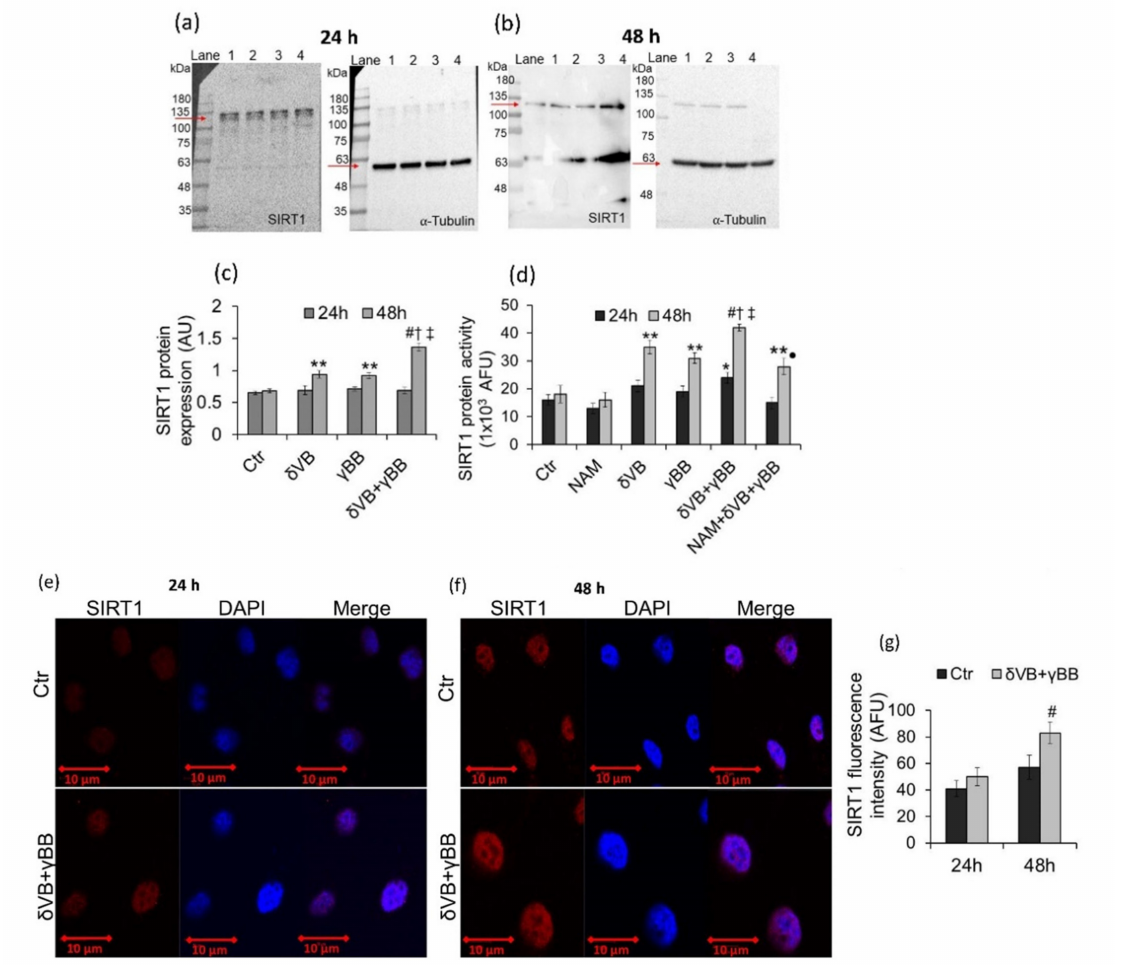
Figure 5. SIRT1 activation by δ VB and γ BB. ( a – c ) SIRT1 protein expression levels were determined in Cal 27 cells after exposure to δ VB (2 mM), γ BB (2.5 mM), or δ VB + γ BB (2 mM + 1.62 mM). Results were expressed as arbitrary units (AU) with ** p < 0.01 vs. Ctr, # p < 0.001 vs. Ctr, † p < 0.05 vs. δ VB, ‡ p < 0.05 vs. γ BB. Lane 1 = Ctr, lane 2 = δ VB, lane 3 = γ BB, lane 4 = δ VB + γ BB. Arrows indicate SIRT1 protein bands at about 110-kDa. Nonspecific bands were detected at lower molecular weight. ( d ) SIRT1 enzyme activity expressed as arbitrary fluorescence units (AFU); * p < 0.05 vs. Ctr, ** p < 0.01 vs. Ctr, † p < 0.05 vs. δ VB, ‡ p < 0.05 vs. γ BB, # p < 0.001 vs. Ctr, • p < 0.01 vs. δ VB + γ BB ( e , f ) Representative confocal images of SIRT1 expression (red) in control (Ctr) cells and cells exposed to δ VB + γ BB. Nuclei were counterstained with DAPI (blue). Scale bar = 10 µ m. (g) Fluorescence intensity values of